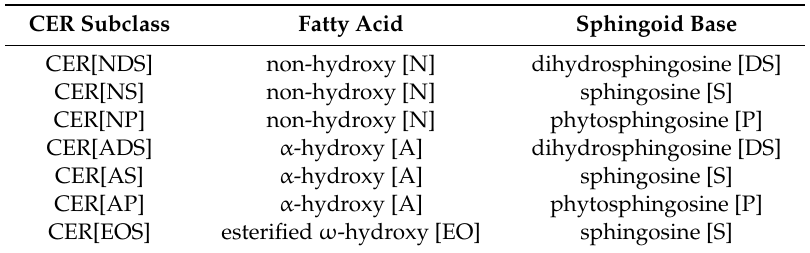
Table 1. Subclasses of ceramides identified in human fibroblasts and keratinocytes according to the nomenclature proposed by Masukawa [14].